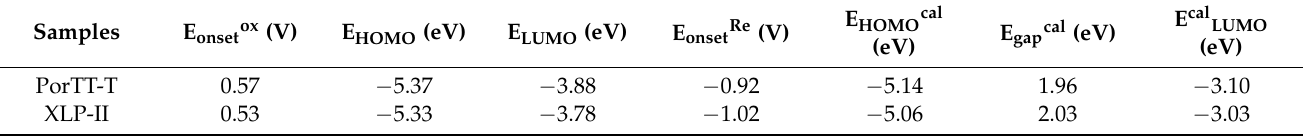
Figure 4. Cyclic voltammetry (CV) curve of PorTT-T flim measured in acetonitrile with 0.1 M tetrabutylammonium hexafluorophosphate (TBAPF 6 ) calibrated with ferrocene/ferrocenium (Fc/Fc + ) as an external reference. Table 3. The CV data and the DFT calculation results.